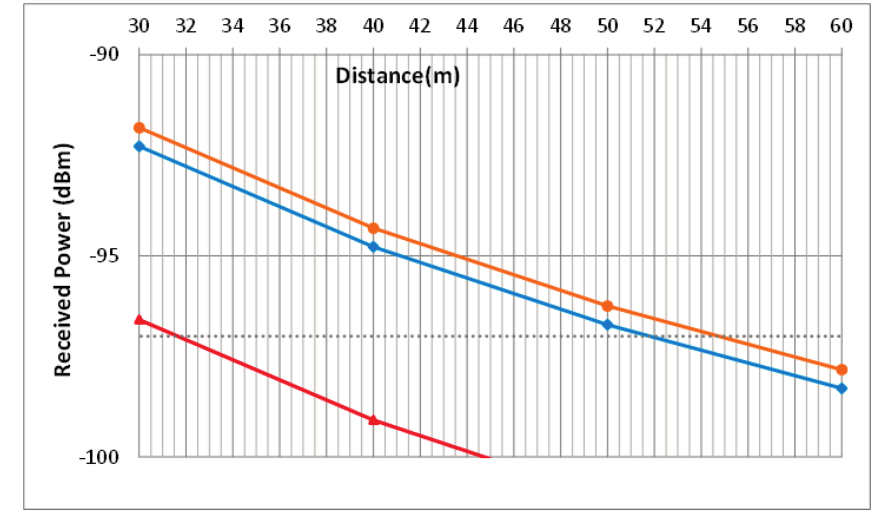
Figure 11. Estimation of maximum distances using Friis formula.